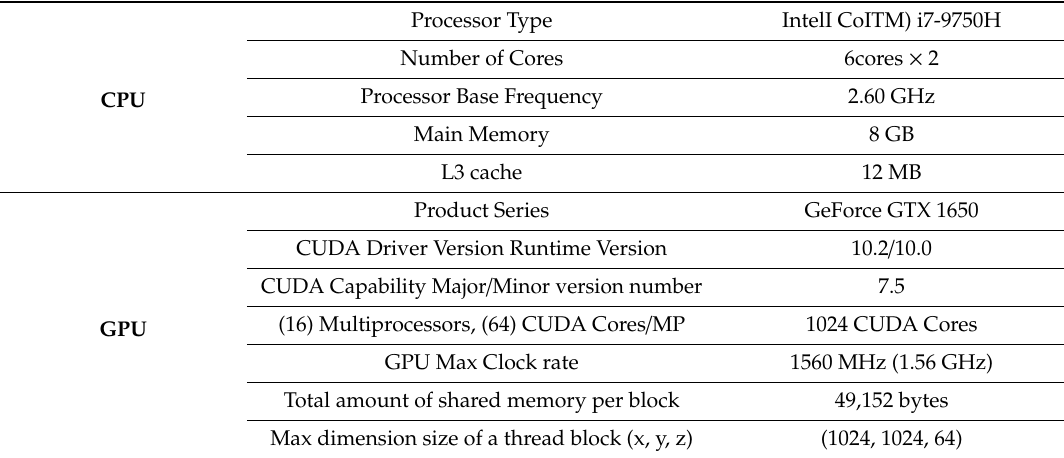
Table 2. Hardware specification of the CPU and GPU.